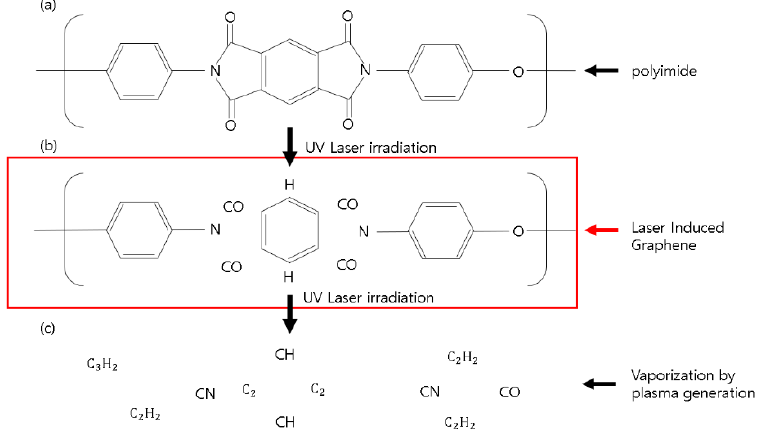
Figure 2. Principle of laser induced graphene (LIG) using a 355 nm pulsed laser: ( a ) polyimide structure, ( b ) structural change of polyimide after laser irradiation, and ( c ) vaporization by plasma generation.